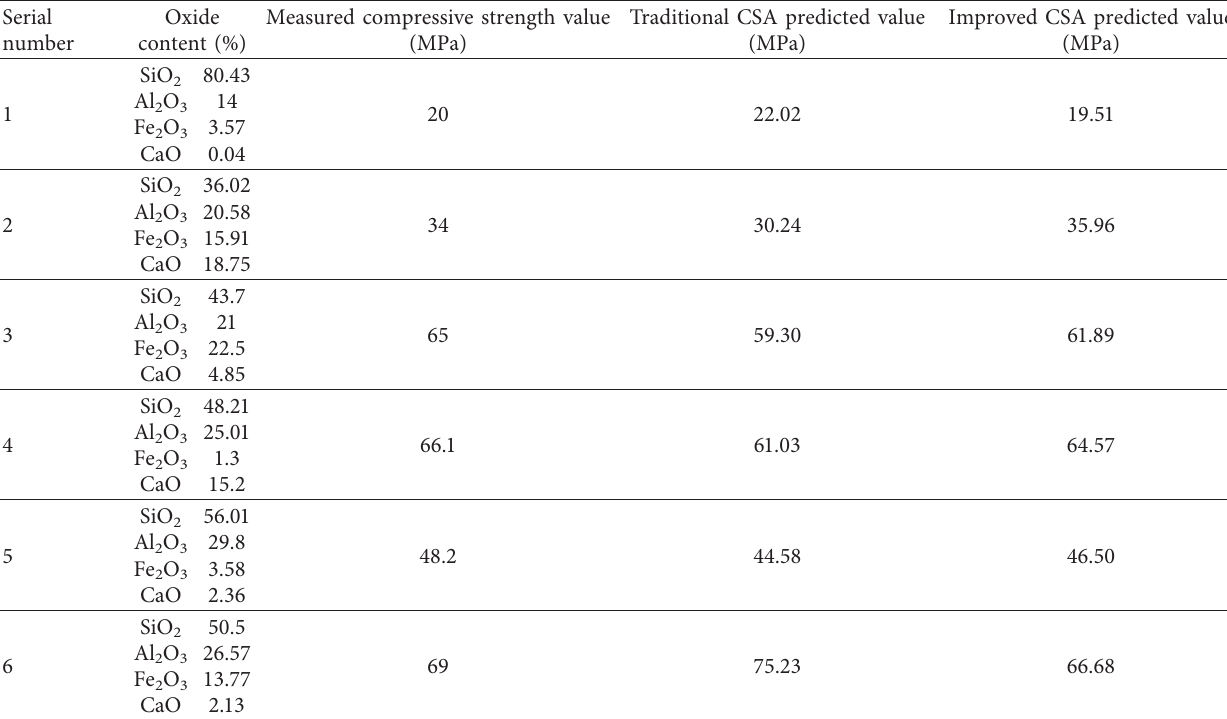
Table 7: Comparison of 28d compressive strength for different oxide